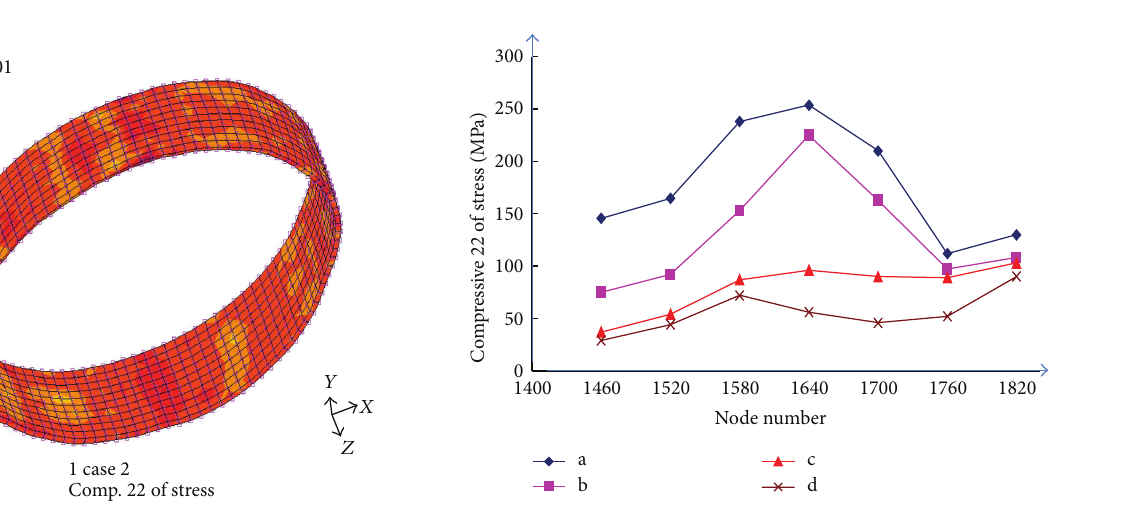
Figure 5: Stress distribution at the reduction ratio of 𝑎 = 40 %, 𝑏 = 35 %, 𝑐 = 30 %, and 𝑑 = 25